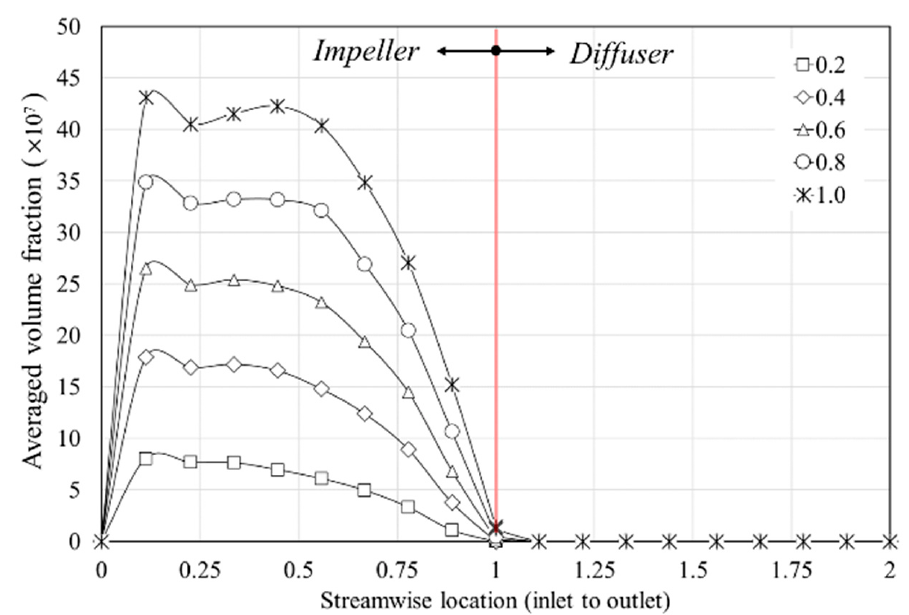
Figure 21. Averaged volume fraction along the streamline position with different water injection rates .